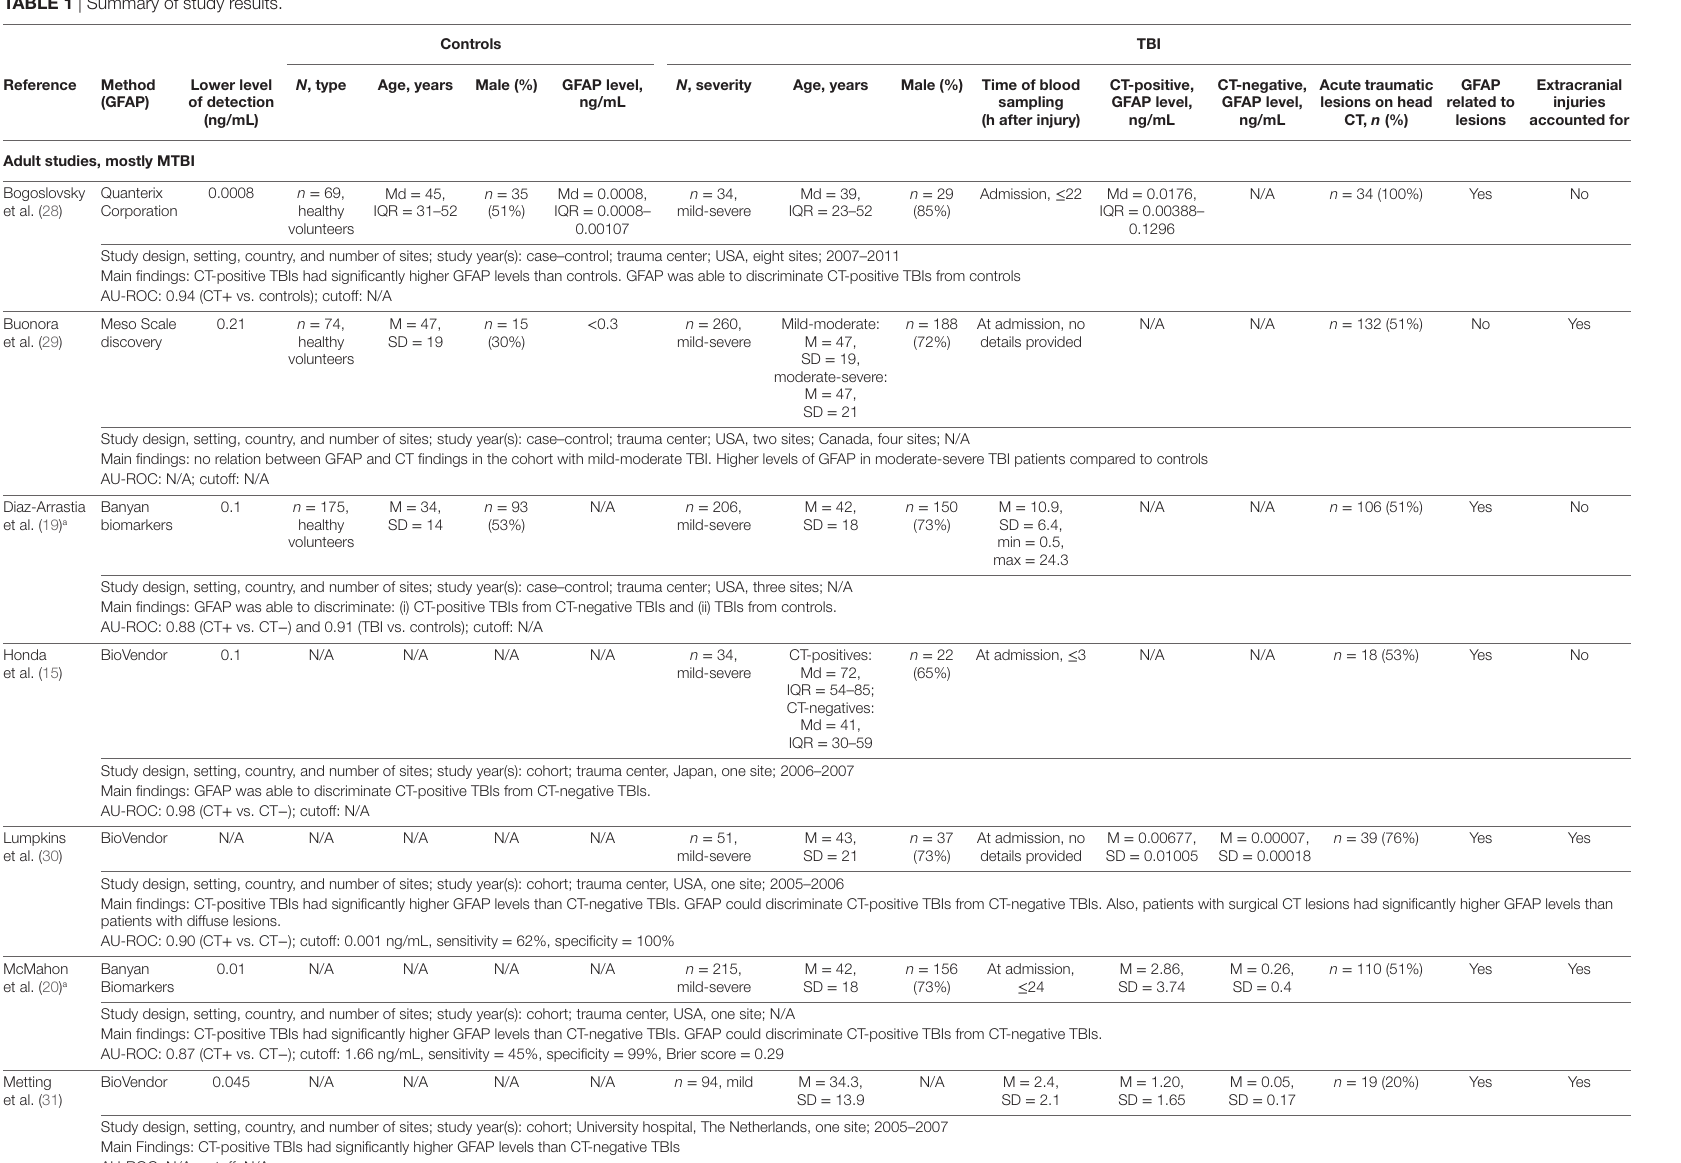
taBLe 1 | Summary of study results.